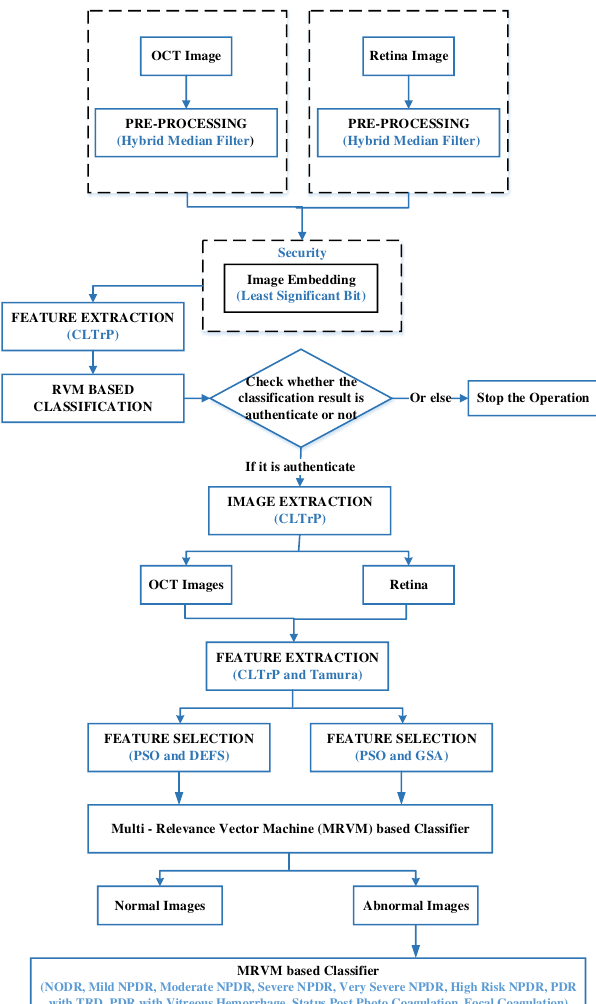
Fig. 2. An overall °ow diagram of the proposed integrated approach for PSO-DEFS and PSO-GSA based feature selection for detection of